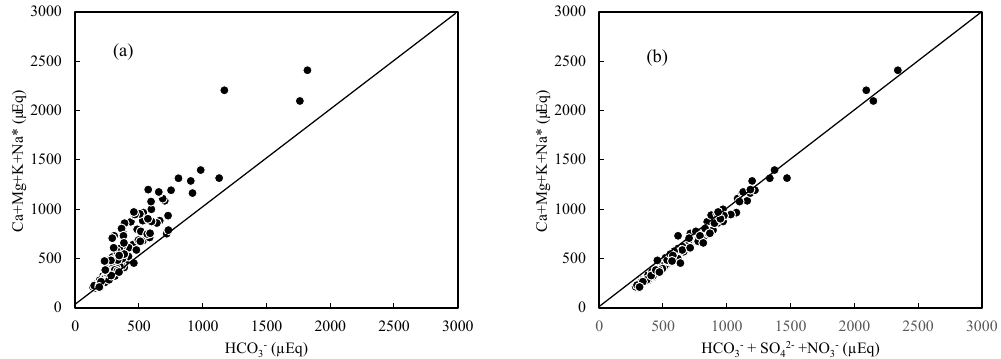
+ SO 2 − + NO − and (b) HCO − for river water 3 3 4 3